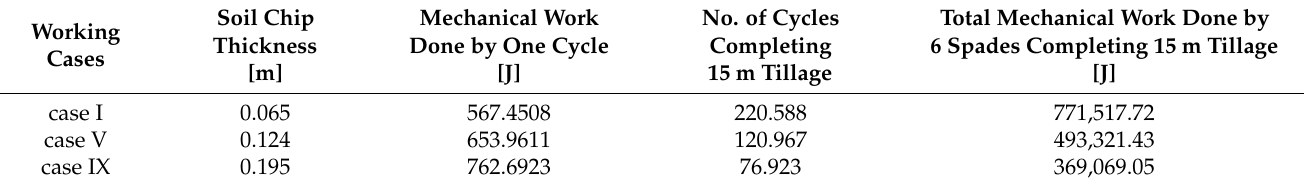
Table 3. Mechanical work done by the spade machine in the three simulated cases.